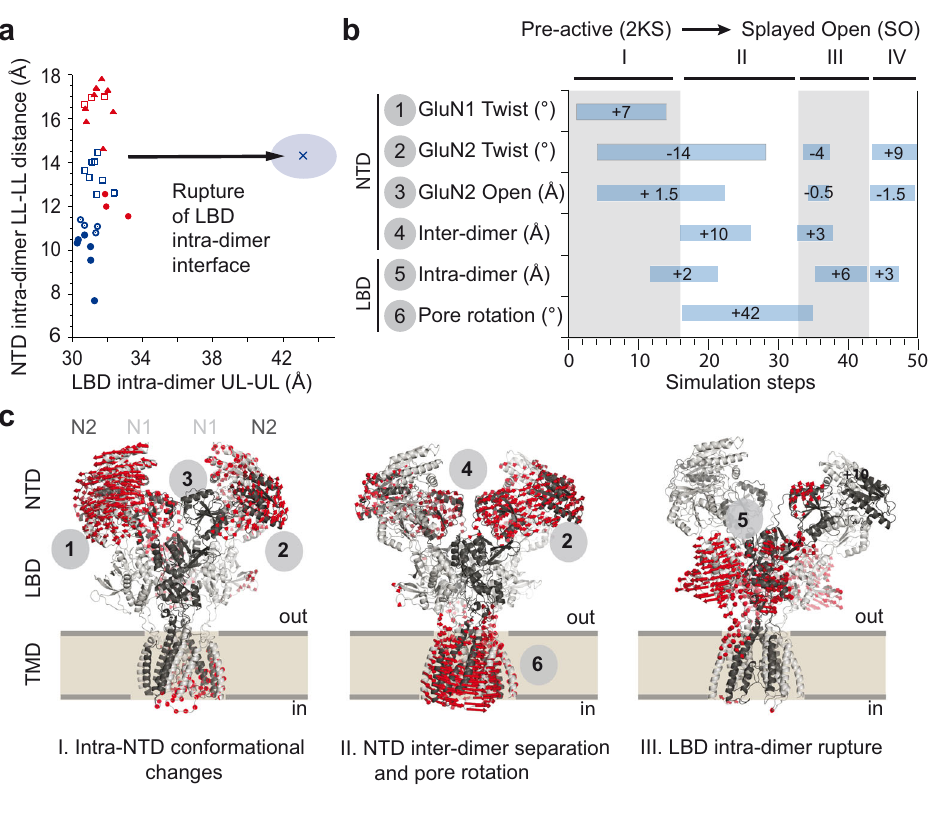
Fig. 7 Long-distance allosteric coupling in GluN2A receptors. a The relationship between the NTD intra-dimer distance and the LBD intra-dimer distance as extracted from 29 available full-length X-ray and cryo-EM NMDAR structures (see “ Methods ” ). Same representation as in Fig. 6f, with blue and red colors for GluN2A and GluN2B receptor structures, respectively, and with an additional GluN2A receptor structure captured in a “ splayed open ” conformation 15 (blue cross). Note that the GluN2A receptor “ splayed open ” structure displays a disrupted LBD intra-dimer interface but an intact NTD intra-dimer interface. NTD N-terminal domain, LBD ligand-binding domain, UL upper lobe, LL lower lobe. b , c iMOD fi t simulations on a full-length GluN2A receptor from the “ pre-active ” state to the “ splayed-open ” state (2KS-6MMR and SO-6MMI, respectively; Ref. 15 ). b Evolution of selected collective variable during the iMODFit simulation. The trajectory is segmented into four consecutive steps (I to IV). Displacement values greater than 2 Å or 6 degree angle between the starting and the targeted structures are indicated within the corresponding rectangles. c Conformational changes experienced by the GluN2A receptor when transiting from the “ pre-active ” to “ splayed-open state ” (steps I to III). Red arrows represent protein displacements occurring during each step. Circled numbers refer to the collective parameters analyzed in panel ( b ). Note that during step III, the LBD intra-dimer interface experiences large structural rearrangement eventually leading to its